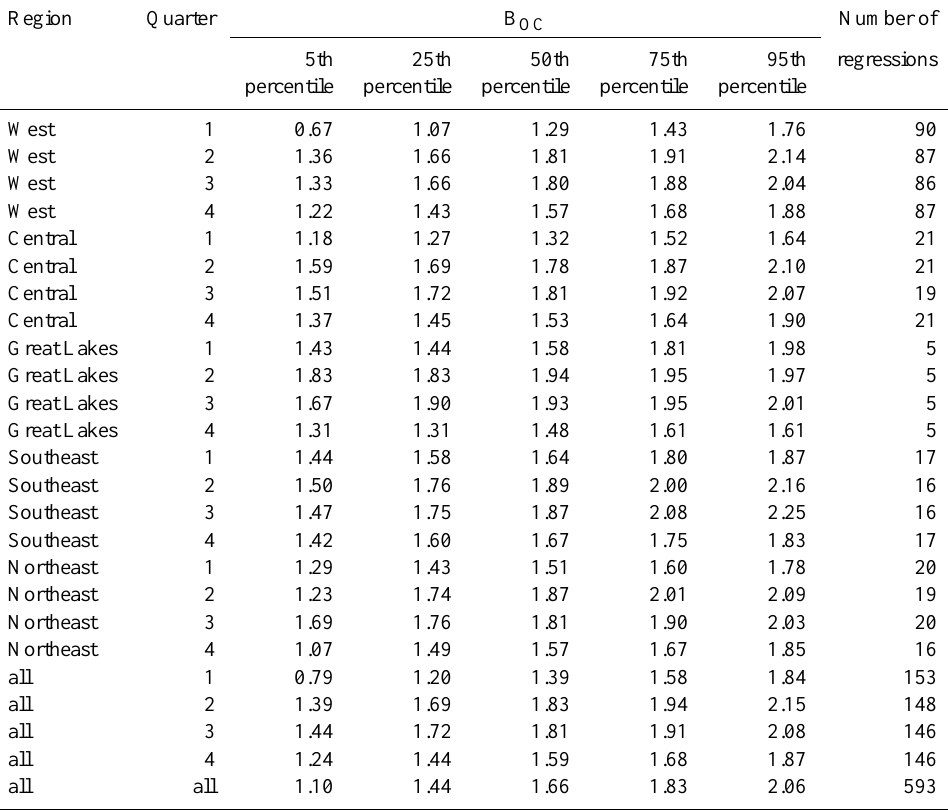
Table 2. Summary of β OC distributions across sites within quarter and region.